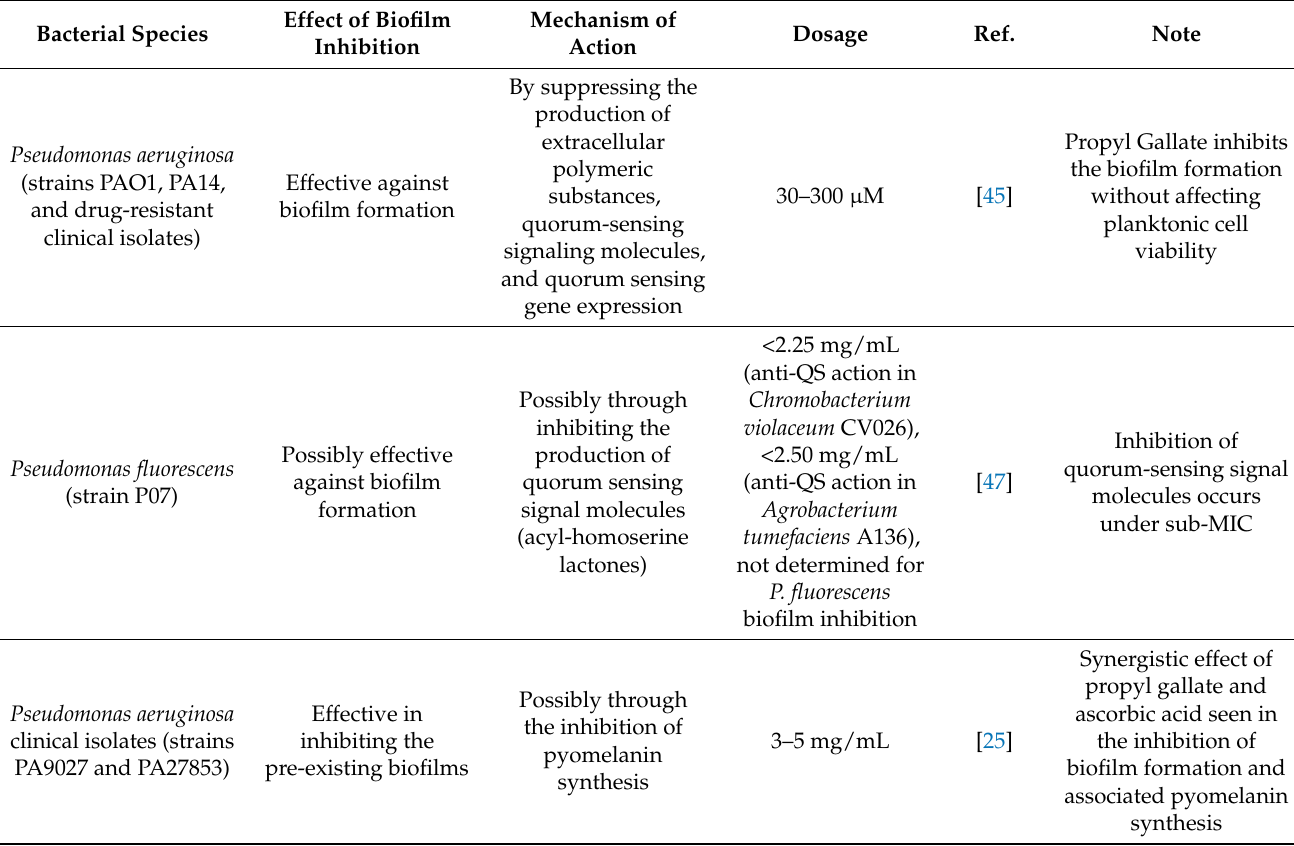
Table 4. Propyl gallate inhibition of biofilm formation by several bacterial species and its suggested mechanisms of